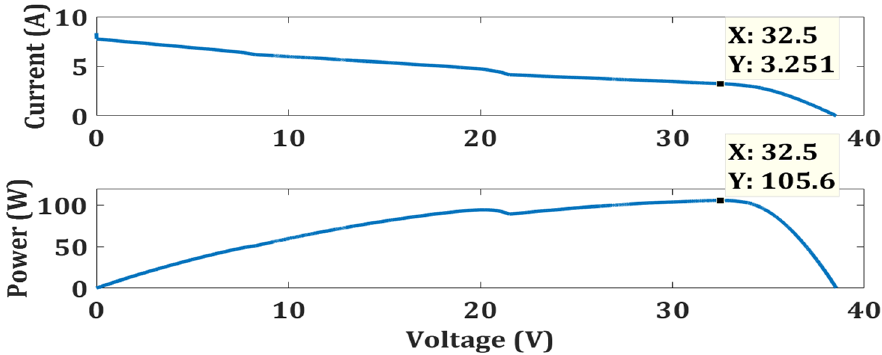
Figure 26. Characteristic curves of 3S2P PV system for test case 2 .